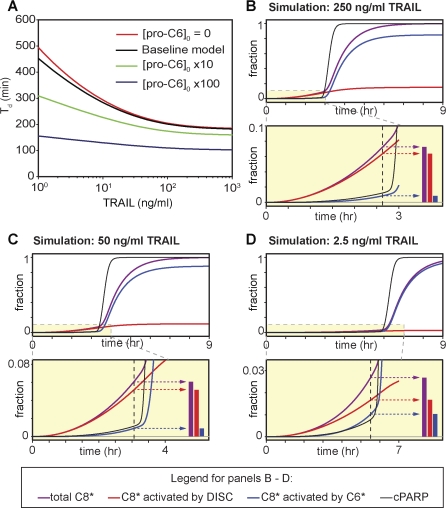
Role of C6 in Modulating the Duration of Pre-MOMP Delay (Td)(A) Simulation showing the effect on Td of increasing the levels of [C6]0 10- (green line) or 100-fold (blue lines) above baseline values (black line) or of eliminating C6 altogether (red line).(B–D) Simulations showing concentrations of total C8* (purple lines) and the subset of C8* generated by DISC (red lines) or by C6* (blue lines) at three different doses of TRAIL. The bottom panels magnify the period immediately before and after snap-action switching; bar plots to the right depict levels of DISC- or C6*-generated C8* (normalized to a total C8* value of 1.0) at the time of MOMP onset (dotted vertical lines).